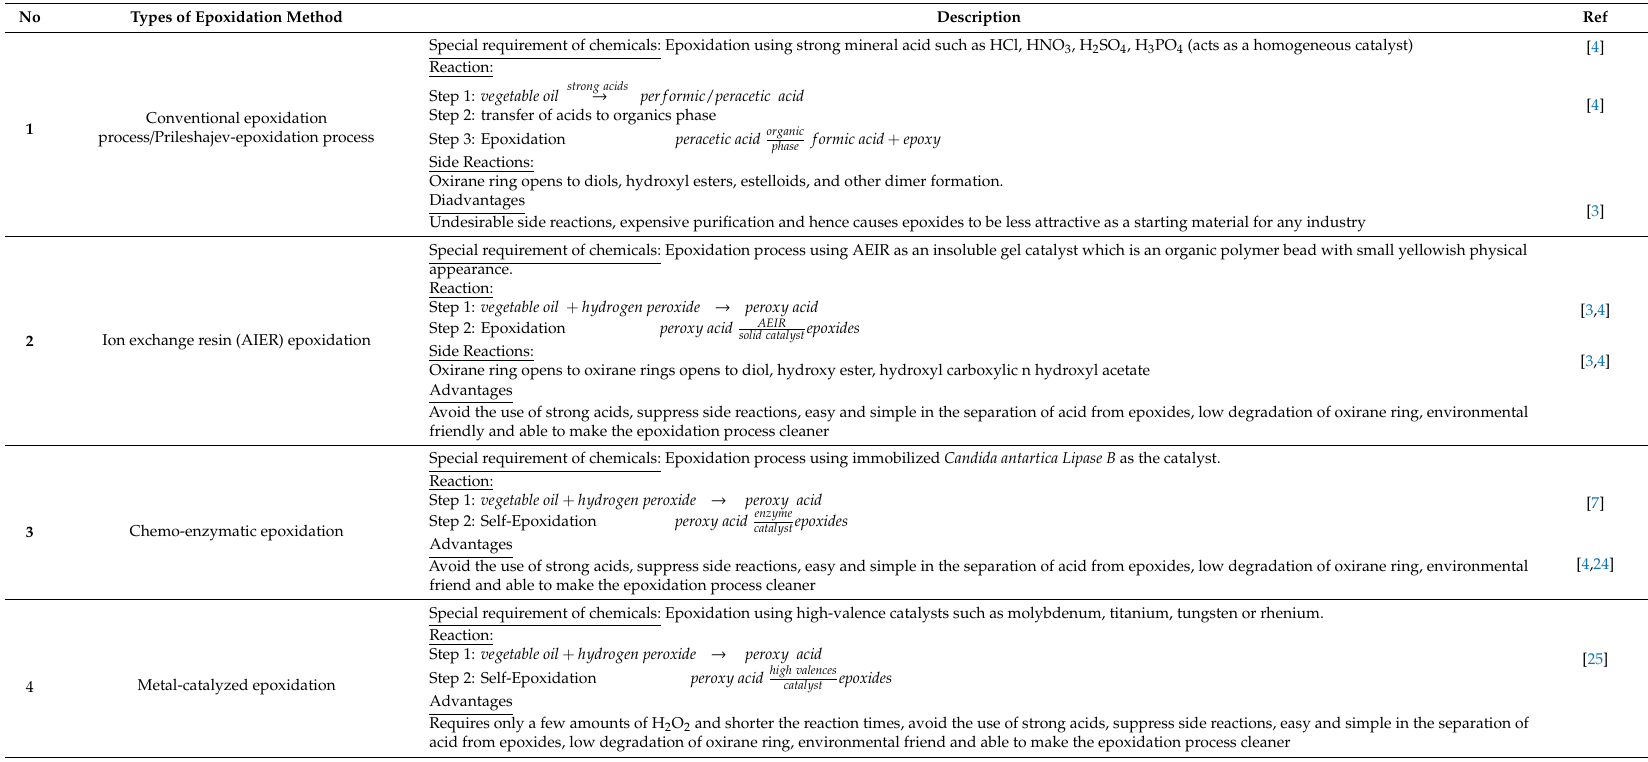
Table 1. Types of Epoxidation